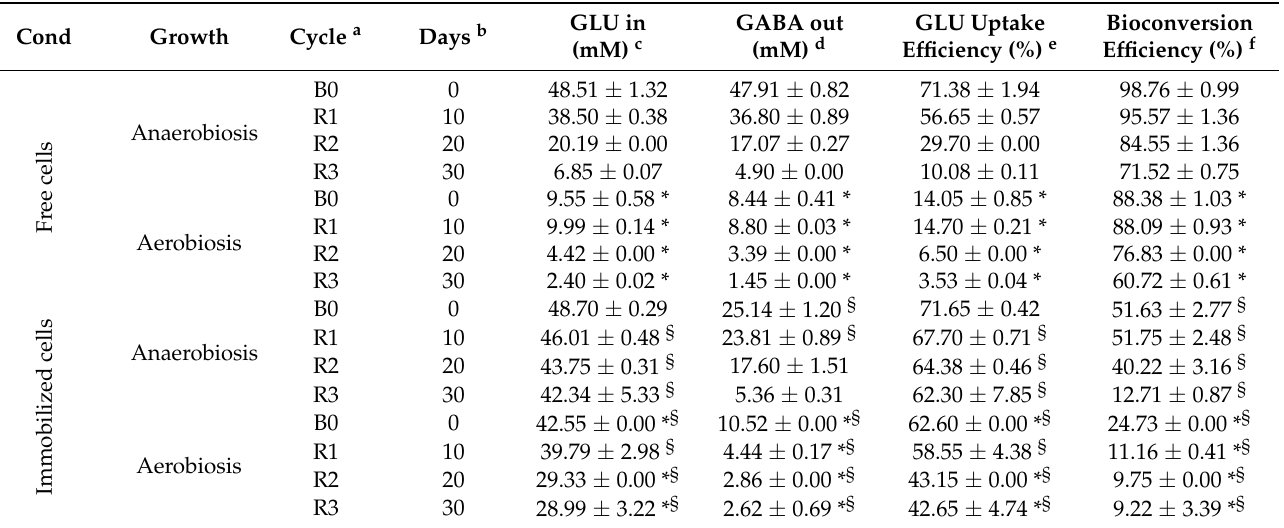
Table 3. Parameters of glutamate to GABA conversion in free and immobilized cells cultivated undern anaerobic and aerobic conditions.